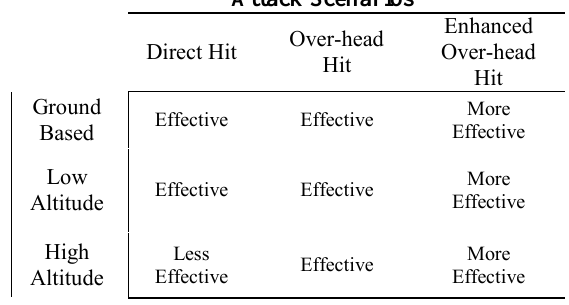
Table 3. The Summerized results of jamming operation against missiles at various scenarios Attack Scenarios Enhanced Over-head Direct Hit Over-head Hit